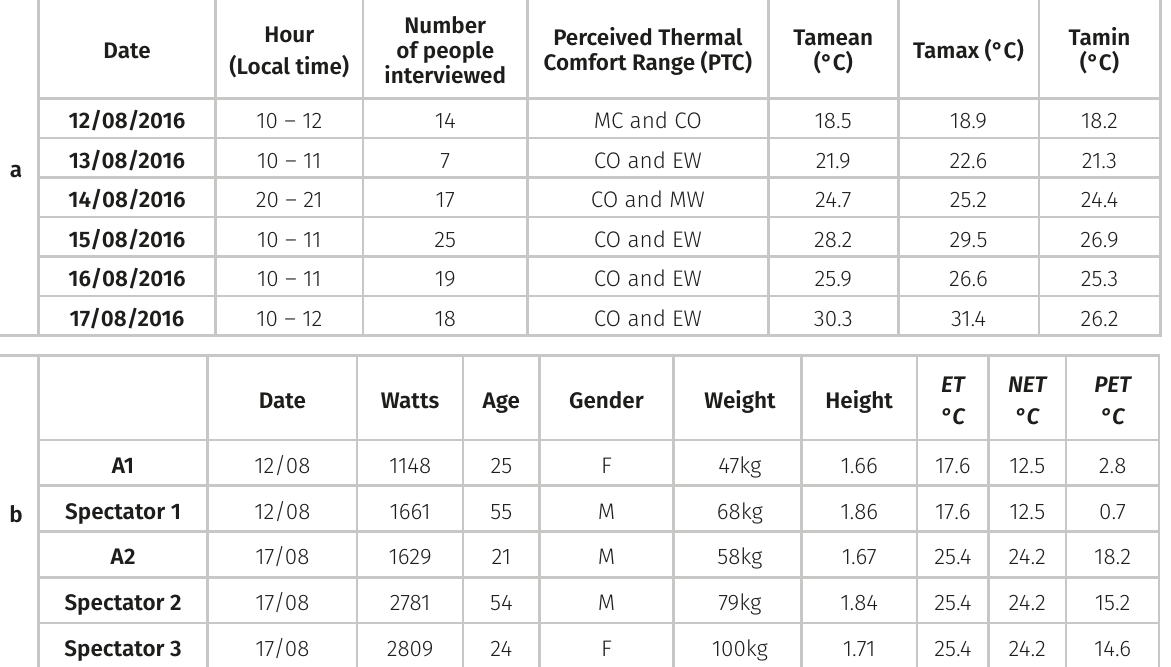
Table III. Time, number of people interviewed, perceived thermal comfort range and mean, maximum and minimum air temperature during the hours of the interviews (a). Tamean, Tamax, Tamin are mean, maximum and minimum temperatures during the interview period. Personal information and thermal comfort indexes for athletes and spectators submitted to observed meteorological conditions (b). For abbreviations of the indices see Section 2 (Theorical